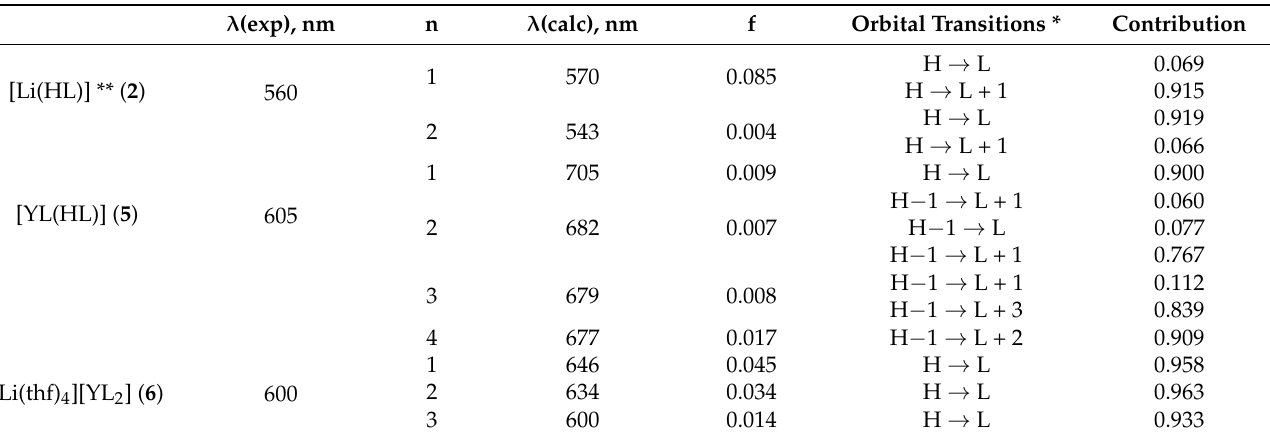
Table 1. Experimental maxima of the long wavelength bands and calculated characteristics of the first vertical S 0 –S n transitions for the compounds; f —oscillator strength, H—HOMO, L—LUMO.